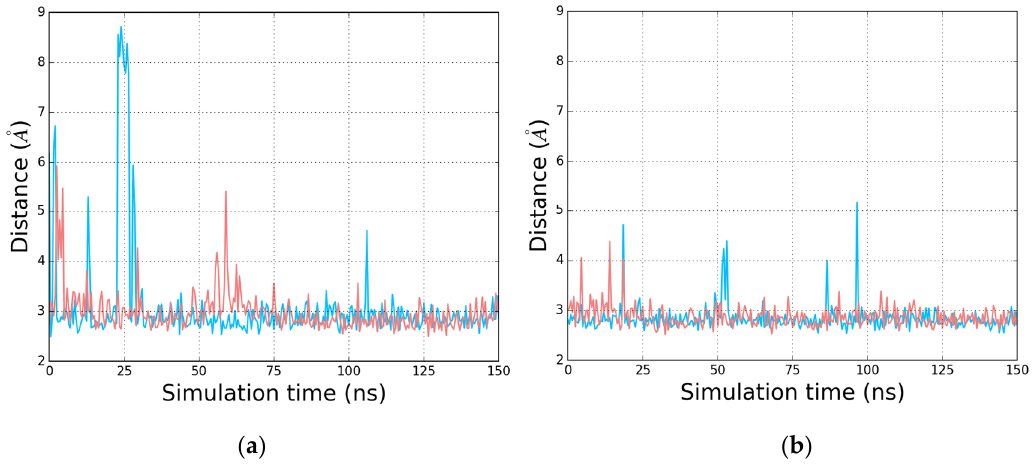
Figure 4. Distance plots for polar interactions between residues from the MT 2 receptor and ( S )- 10 ( a ) or ( R )- 10 ( b ) during 150 ns of molecular dynamics (MD) simulation of the ligand-receptor complexes. The distance between the methoxy oxygen of the ligand and the amide nitrogen of Asn175 4.60 is shown in orange; the distance between the amide carbonyl oxygen of the ligand and the amide nitrogen of Gln194 ECL2 is shown in cyan.